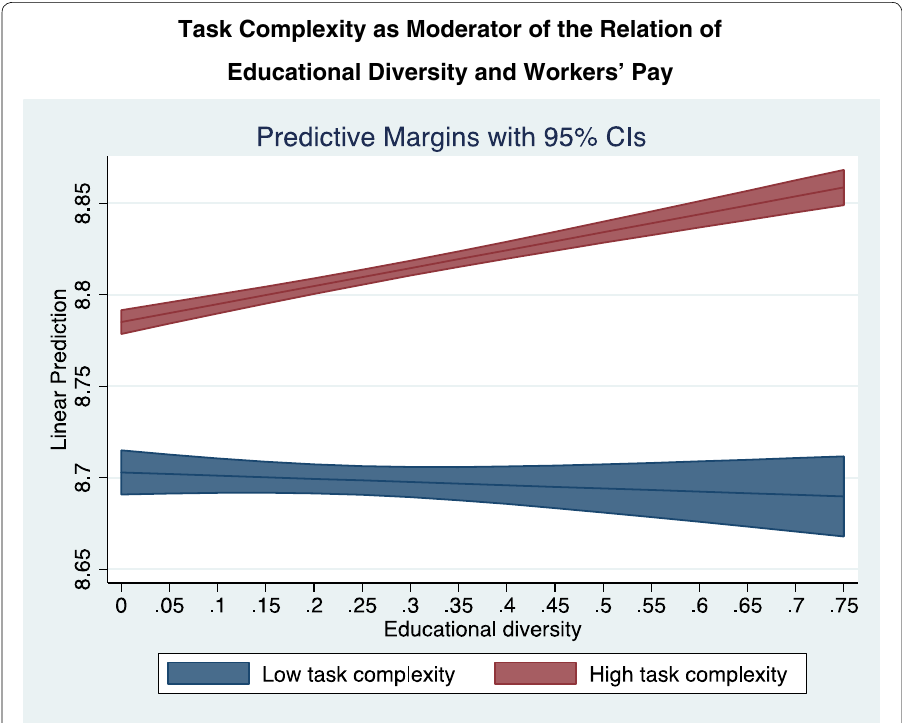
Figure 2 Task complexity as moderator of the relation of educational diversity and workers’ pay. Source: Authors’ calculations with data from the